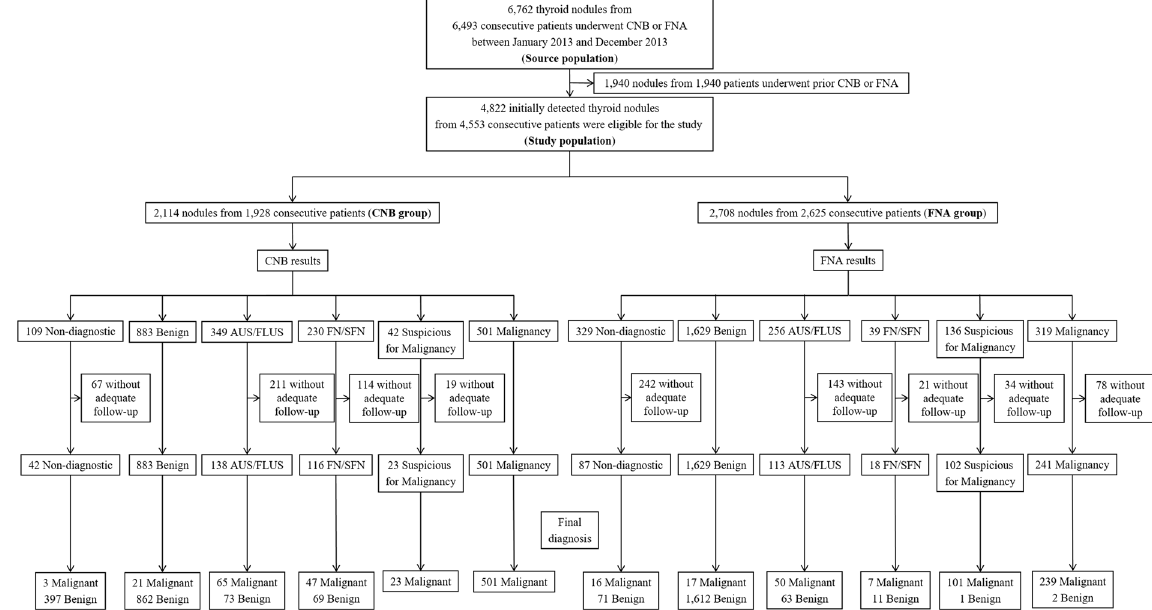
Figure 1. Patient flow and study outcomes in the study patients. Numbers represent the number of thyroid nodules. CNB = core-needle biopsy, FNA = fine-needle aspiration, AUS = atypia of undetermined significance, FLUS = follicular lesion of undetermined significance, FN = follicular neoplasm, SFN = suspicious for a follicular neoplasm, US =